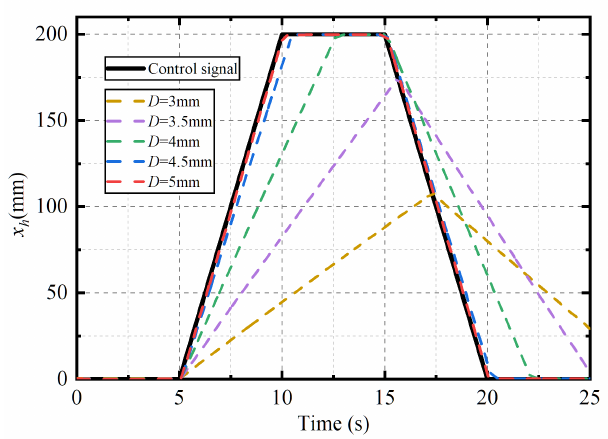
Figure 16. Displacement output, x h , at different inner diameter of slender pipiline, D , when depth is 11